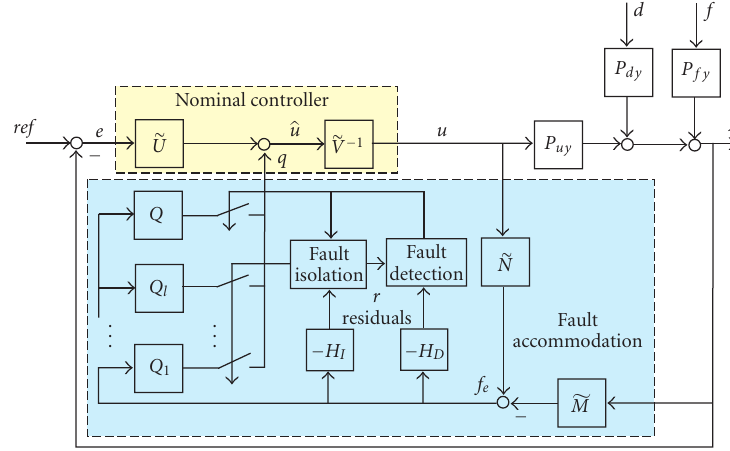
Figure 5: GIMC accommodation